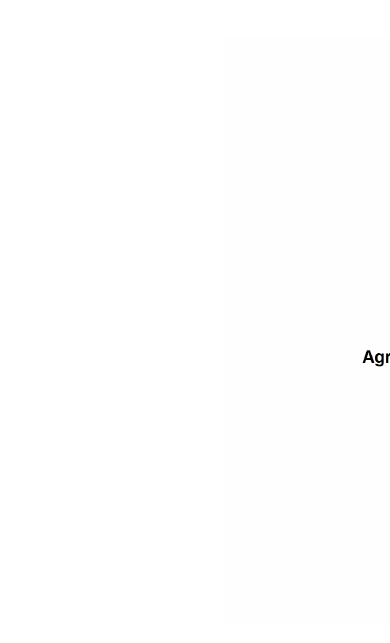
Figure B3. Map of aggregated simulated land cover across the 10 evaluation simulations initialised with no baseline land use map. Baseline land cover is shown on the map, with opacity scaled to show the number of evaluation simulations in which that land cover occurred at the 300th time step.